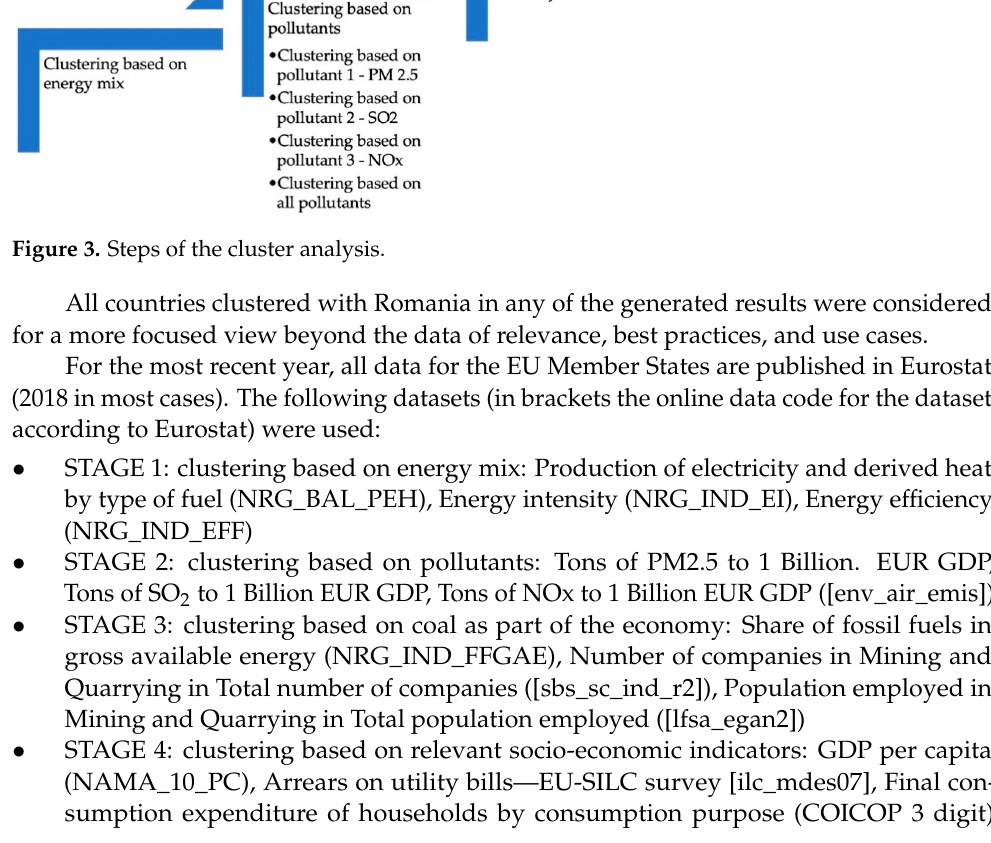
Figure 3. Steps of the cluster analysis.